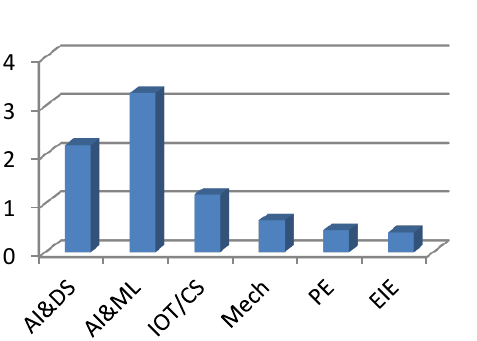
Figure 6: Weights of alternatives with respect to C 6